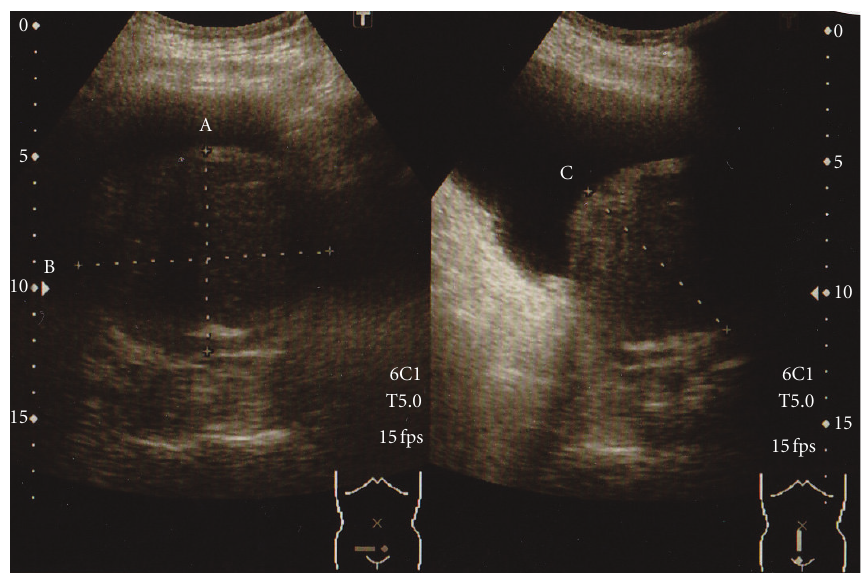
Figure 1: Transabdominal ultrasonography of large BPH in Case 1.